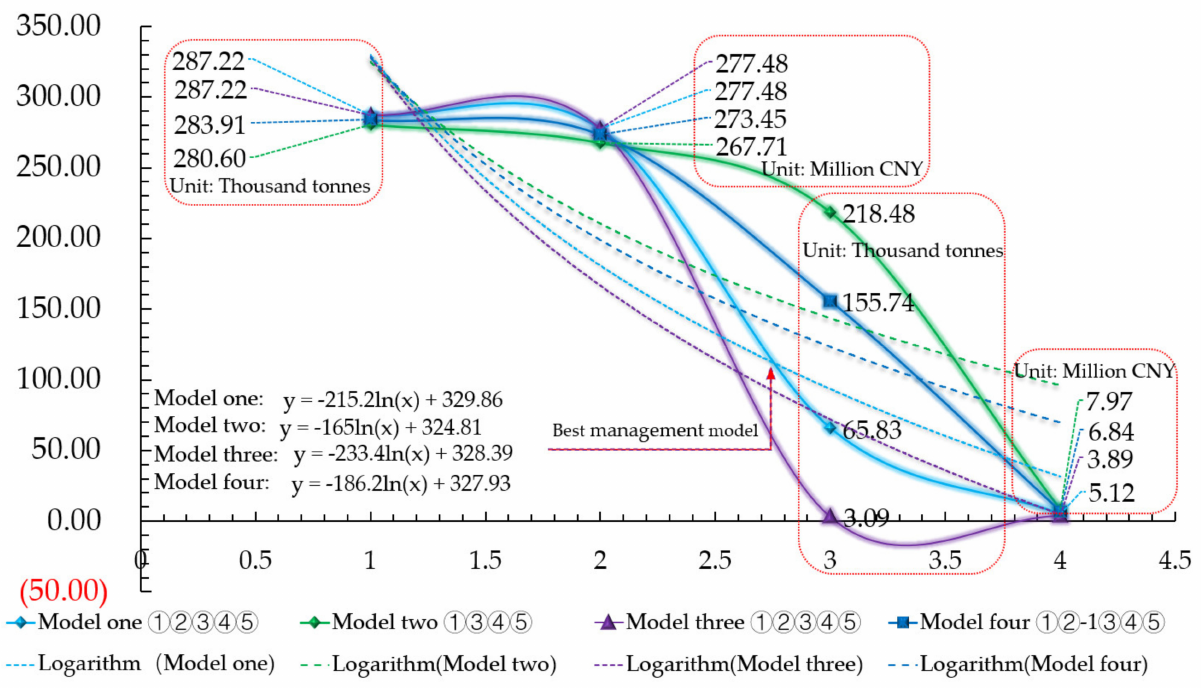
Figure 16. Comparative analysis of four model curve